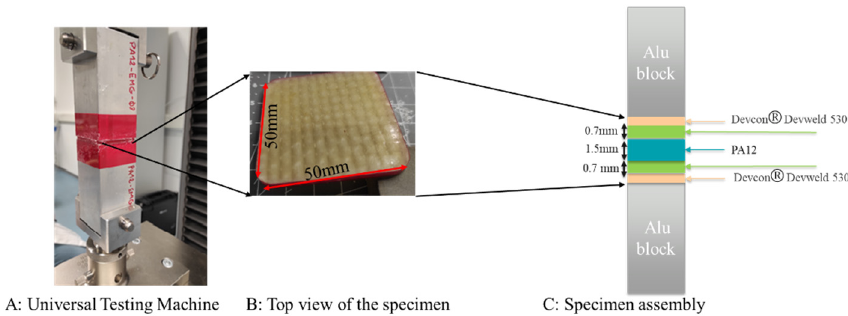
Figure 6. Schematic of assembled samples for flatwise test according to ASTM C297.